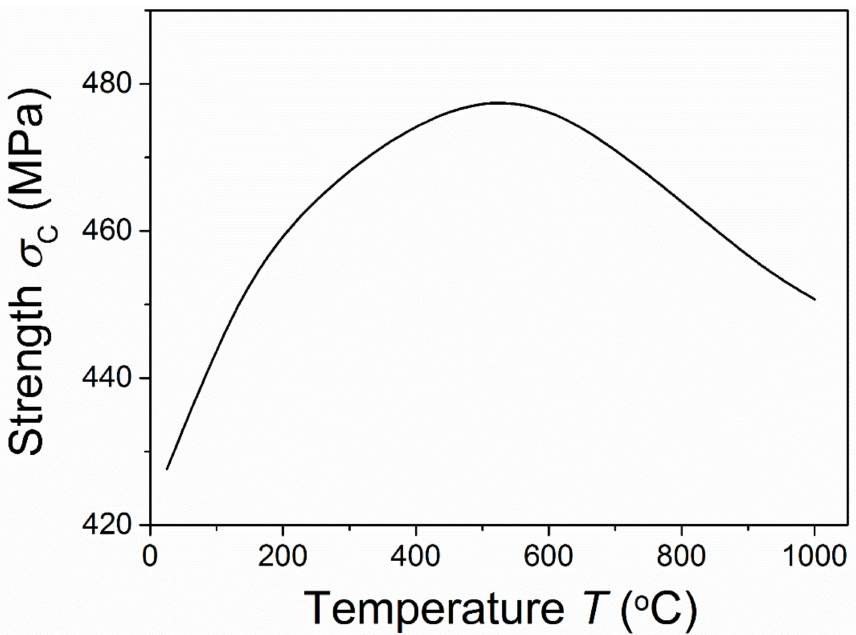
Figure 5. Temperature-dependent critical applied stress (strength) for stable crack